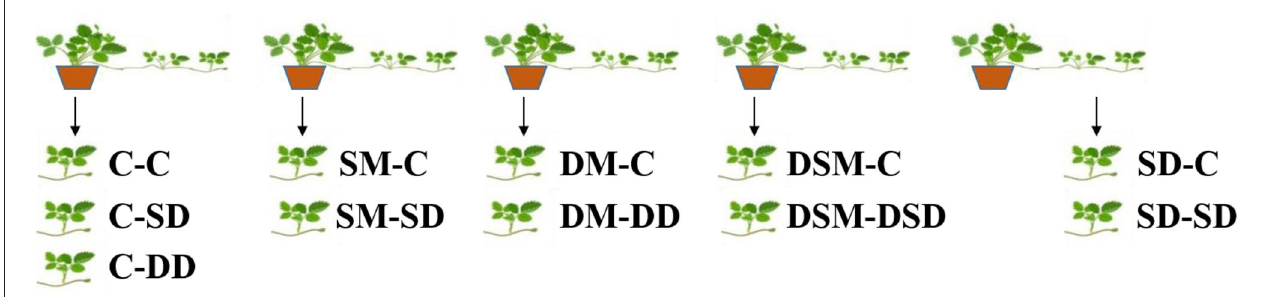
FIGURE 1 | Methods of Si application for strawberries. Respectively: C-C, no Si application during cutting propagation; C-SD, no Si application before cutting propagation and the daughter plants sprayed with the Si solution after cutting propagation; C-DD, no Si application before cutting propagation and the daughter plants drenched with the Si solution after cutting propagation; SM-C, the mother plants sprayed with the Si solution before cutting propagation and no Si application after cutting propagation; SM-SD, the mother plants sprayed with the Si solution before cutting propagation and the daughter plants sprayed with the Si solution after cutting propagation; DM-C, the mother plants drenched with the Si solution before cutting propagation and no Si application after cutting propagation; DM-DD, the mother plants drenched with the Si solution before cutting propagation and the daughter plants drenched with the Si solution after cutting propagation; DSM-C, the mother plants dressed with the soluble Si fertilizer before cutting propagation and no Si application after cutting propagation; DSM-DSD, the mother plants dressed with the soluble Si fertilizer before cutting propagation and the daughter plants dressed with the soluble Si fertilizer after cutting propagation; SD-C, the daughter plants sprayed with the Si solution before cutting propagation and no Si application after cutting propagation; or SD-SD, the daughter plants sprayed the Si solution before and after cutting